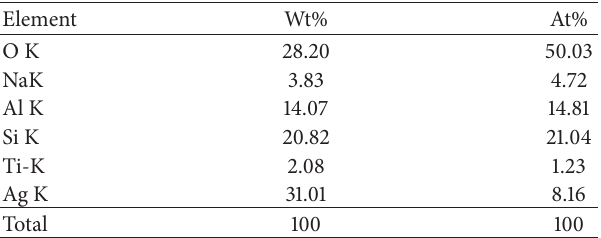
Table 6: Cytotoxic screening of the novel synthesized Ti-Zeolite-A exchanged by Ag against the tested human cancer cell lines.